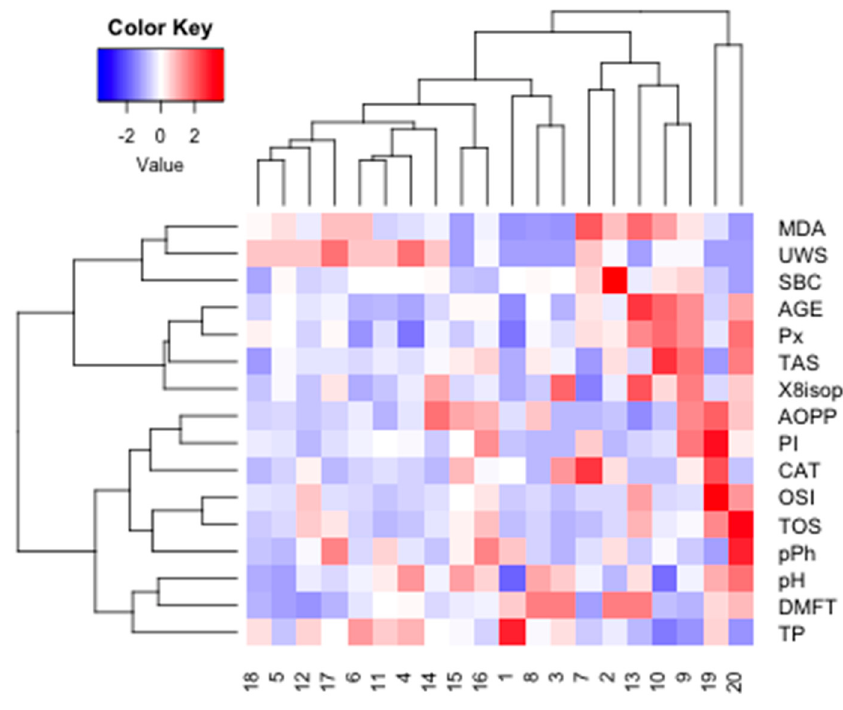
Figure 19. Cluster analysis for group PC. PC, patients with breast cancer and with the BRCA1 mutation; AOPP, advanced oxidation protein products; TP, total protein; OSI, oxidative stress index; TOS, total oxidant status; TAS, total antioxidant status; CAT, catalase activity; pPh, total phenolic content; Pl.I score, Plaque Index; DMFT, decay, missing, filled teeth; UWS, unstimulated whole